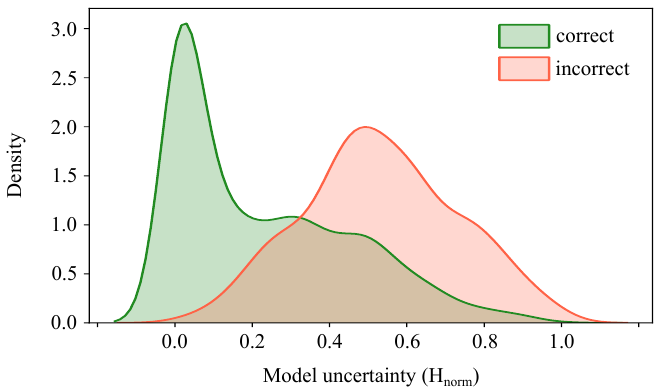
Figure 6. Distribution of normalized uncertainty values ( H norm ) for all test samples grouped as correct and incorrect predictions. It shows that model uncertainty is higher for incorrect predictions. Therefore, it serves as complementary information to refer the uncertain samples to experts and improve the overall prediction performance of the automated system. Kernel density estimation with a Gaussian kernel is used to plot the output posterior